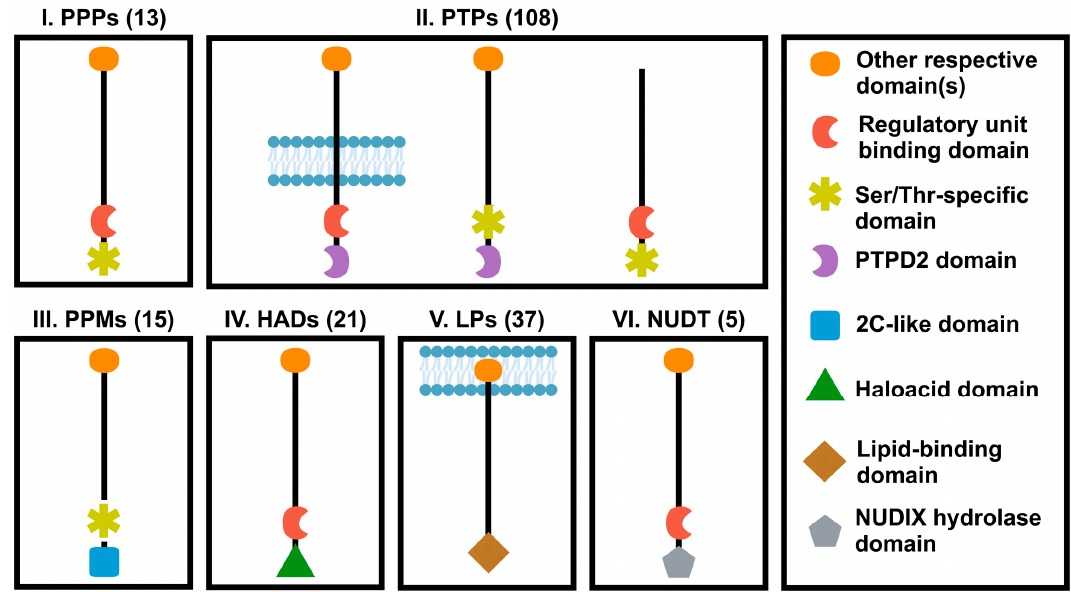
Figure 2. Classification of phosphatase superfamily. Protein phosphatases were classified into six different families according to the catalytic domains. PPP, phosphoprotein protein phosphatase family; PTPs, protein tyrosine phosphatase domain family; PPM, protein phosphatase 2C-like domain family; HAD, Haloacid dehalogenase-like hydrolase domain family; PPTD2, distal PTP domain; LPs, lipid domain family; NUDT, NUDIX hydrolase domain family. Numbers in parenthesis represent numbers of genes in each family.